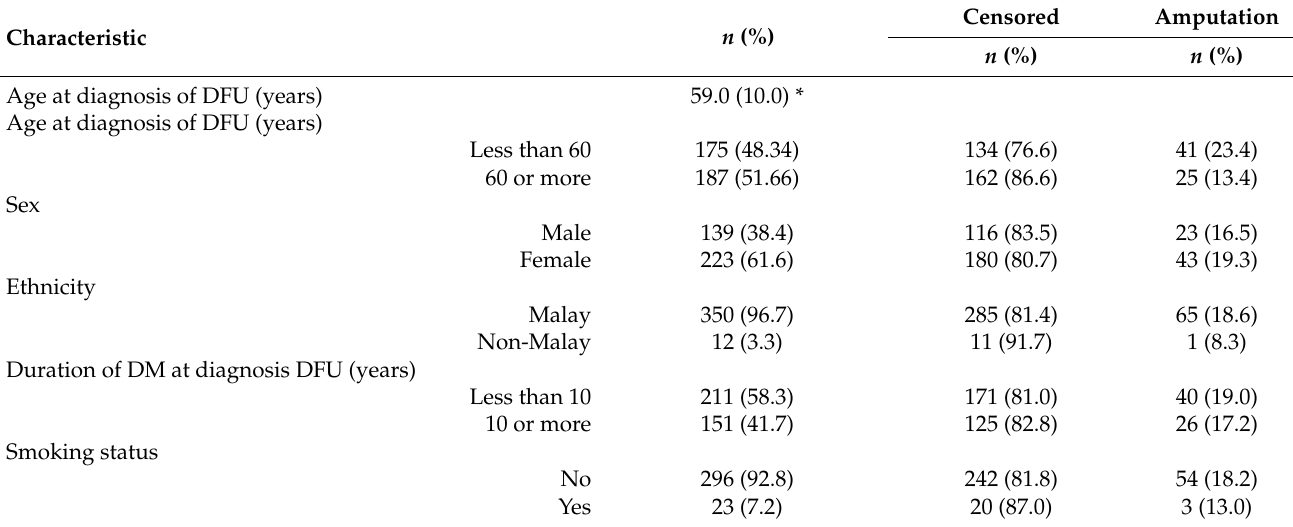
Table 1. Characteristics of patients with DFU in Kelantan from 2014 to 2018.